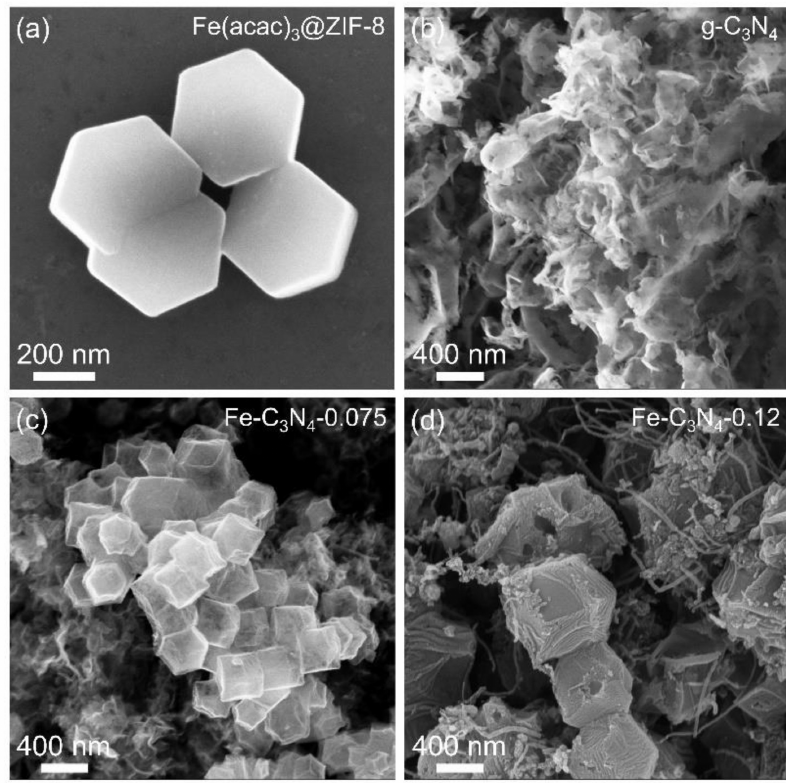
Figure 1. SEM images of ( a ) Fe(acac) 3 @ZIF-8, ( b ) g-C 3 N 4 , ( c ) Fe-C 3 N 4 -0.075 and ( d ) Fe-C 3 N 4